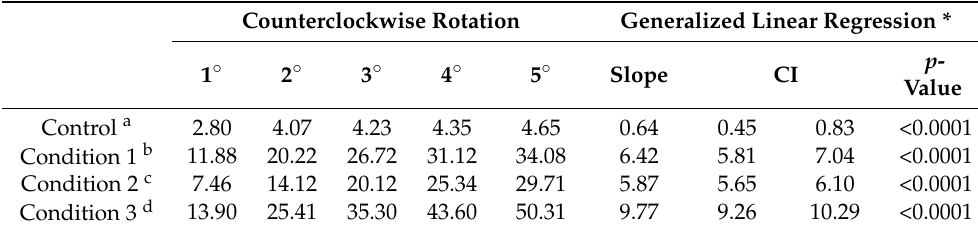
Table 4. Moment (Nmm) required to unwind the orthodontic miniscrew at the middle of the cortical bone in each degree of counterclockwise rotation.